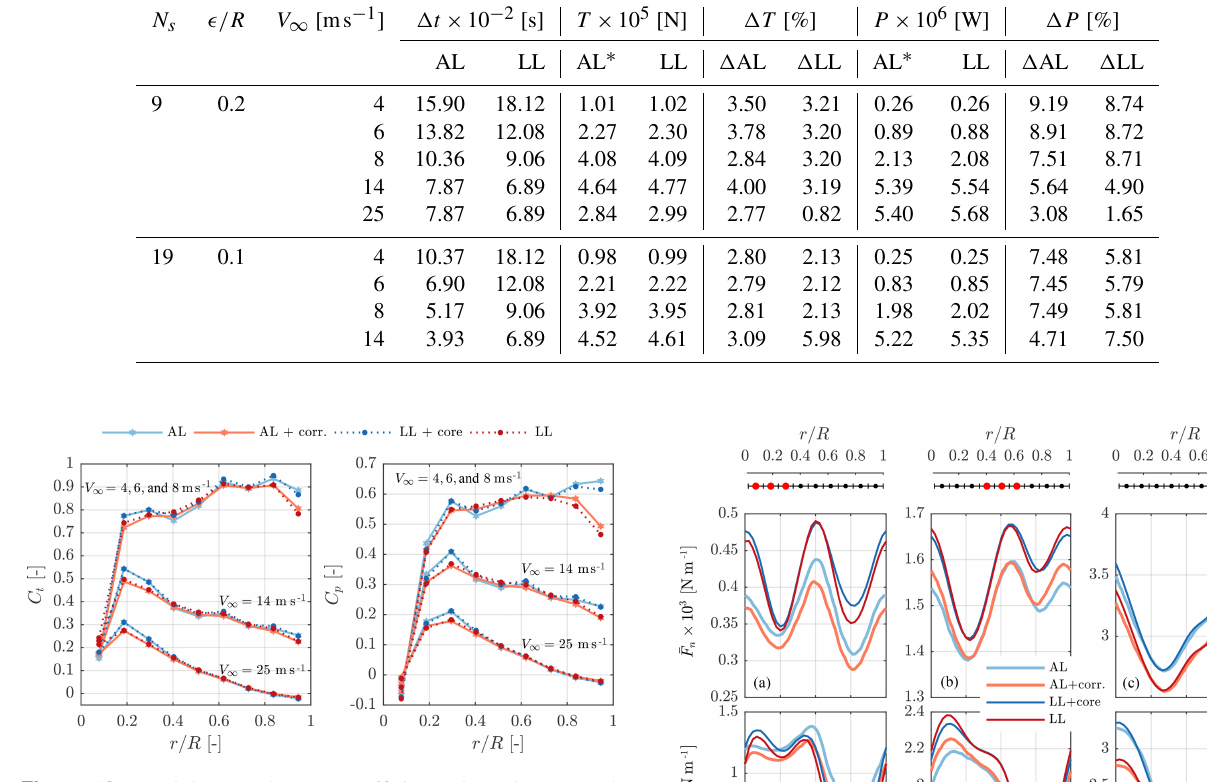
Figure 12. Local thrust and power coefficients along the NREL 5- MW blades at different wind speeds predicted by AL simulations with/without smearing correction and LL with/without core ( N s = 9, (cid:15) = 0 . 2 R ).